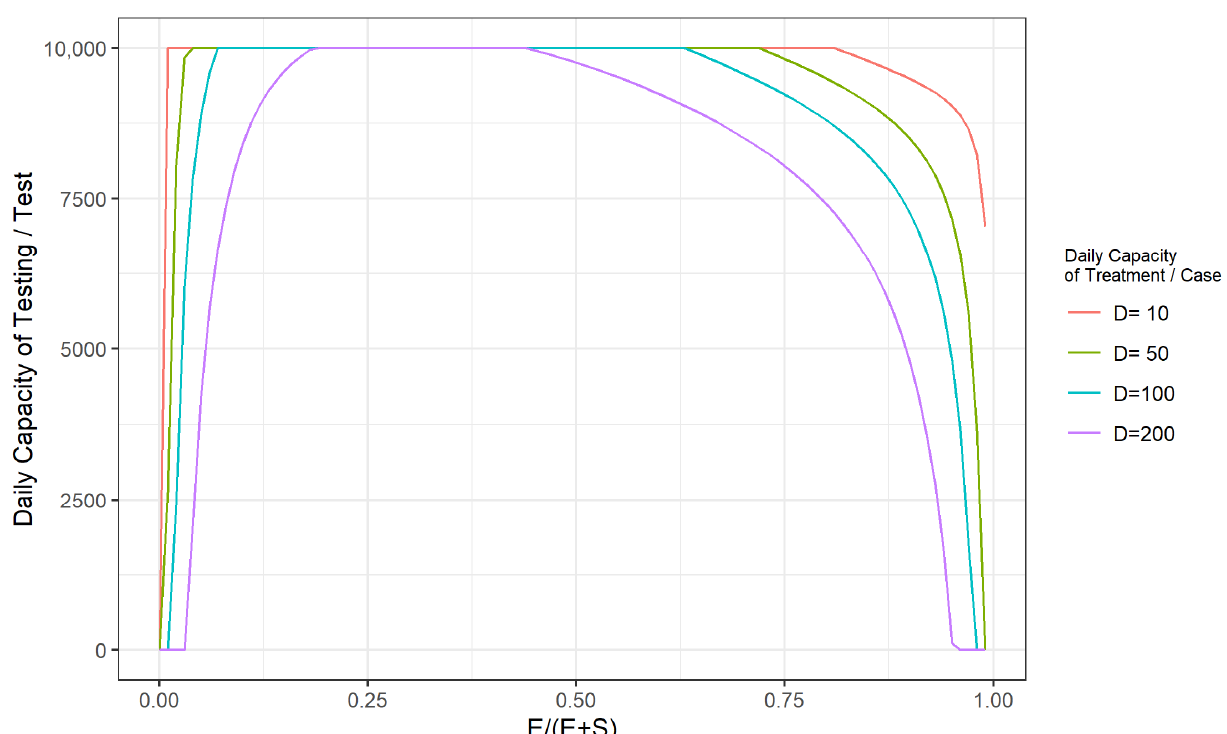
Figure A6. The influence of the daily testing capacity of 3000 person on the evolutionary process of the epidemic; (The unit of the ordinate is “person”).